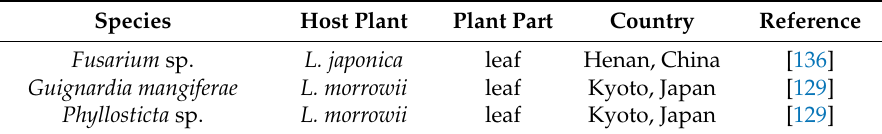
Table 12. Endophytic fungi isolated from Lonicera species.